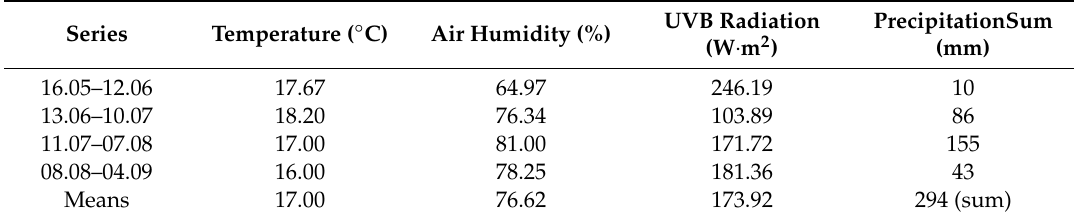
Table 3. Mean values of meteorological parameters (temperature, air humidity, and ultraviolet B (UVB) radiation) and the sum of precipitation for series.